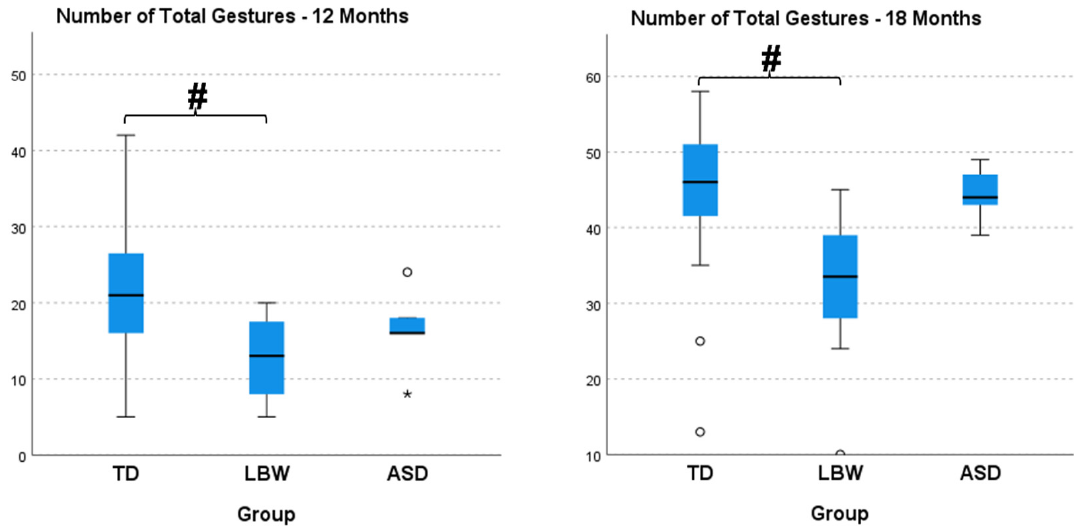
Figure 3. Number of total gestures at 12 and 18 months of age from the MacArthur-Bates Commu- nicative Development Inventories (CDIs). TD, infants with typical development; LBW, infants born prematurely and with low birth weight; ASD, infants with a sibling diagnosed with ASD. The # sign indicates significant differences between groups, while the * and ° denote outliers.